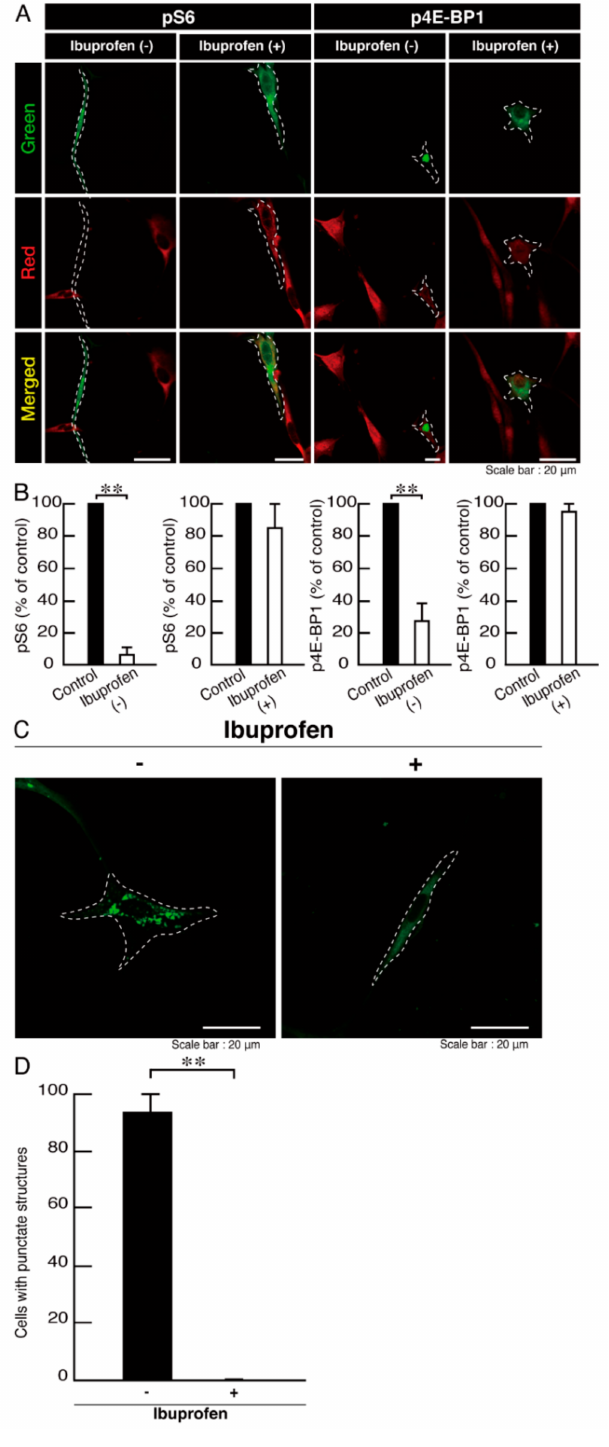
Figure 12. Ibuprofen reverses phosphorylation levels of ribosomal S6 and 4E-BP1 proteins and aggregate-like punctate structures in cells harboring the POLR3A mutants. ( A , B ) FBD − 102b cells harboring the R140X constructs (green) in the presence or absence of ibuprofen were stained with an anti-(pS240 and pS244) ribosomal S6 protein (pS6) or anti-(pT37)4E-BP1 (p4E-BP1) antibody (red). Their phosphorylation levels are shown statistically compared to those in their respective control cells under each image (** p < 0.01; n = 3 fields). ( C , D ) Cells were treated with or without ibuprofen. Percentages of cells with punctate structures were statistically assessed (** p < 0.01; n = 3